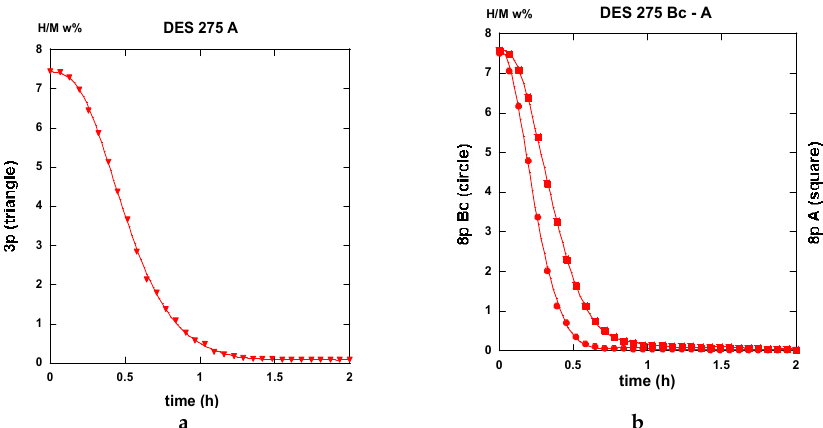
Figure 28. Hydrogen desorption rate (H/M w%) for: a —A-mode ECAP treated at 275 °C for 3 passes b —B C - and A-mode ECAP- treated for 8 passes at 275 °C.